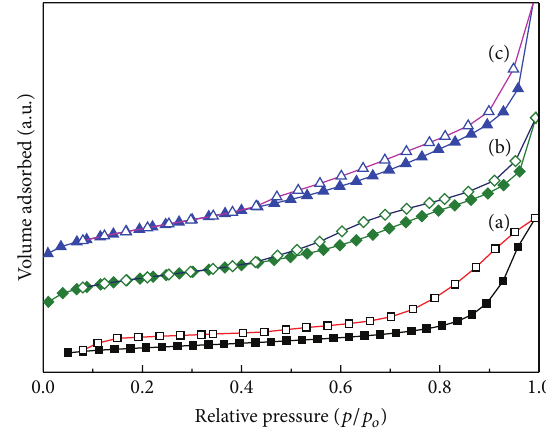
Figure 7: N 2 adsorption isotherms of MIL-53 (Fe) samples with different crystallization time. (a) 1 day, (b) 3 days.